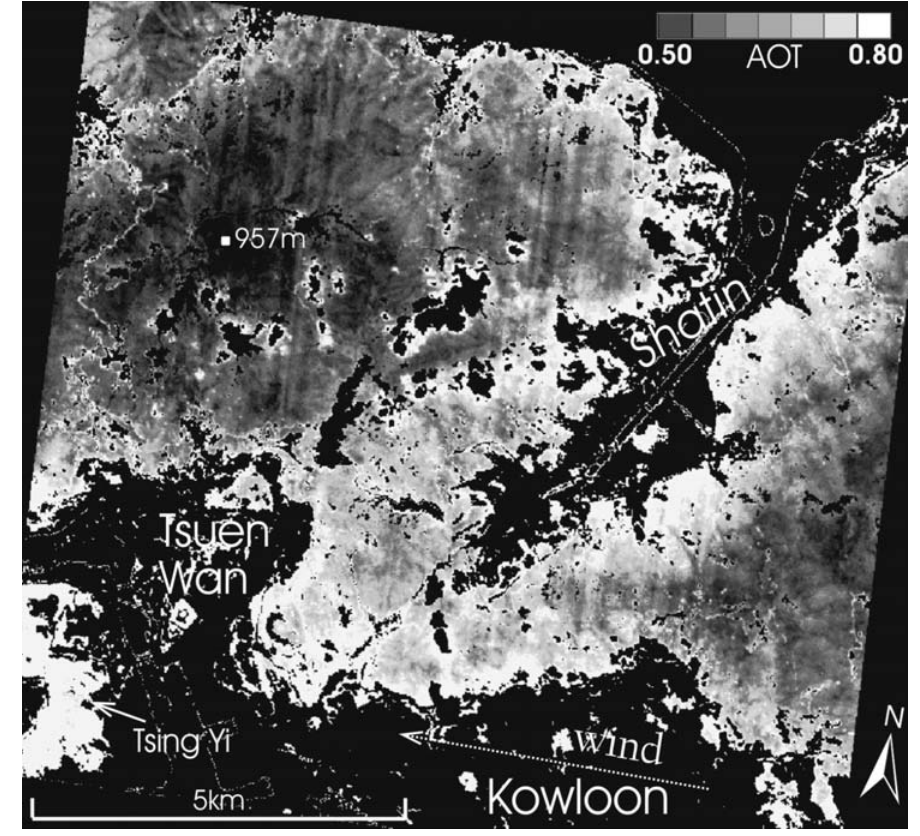
Figure 4 . AOT image on 27-Sep-2006. Null values (black) are given for non-DDV